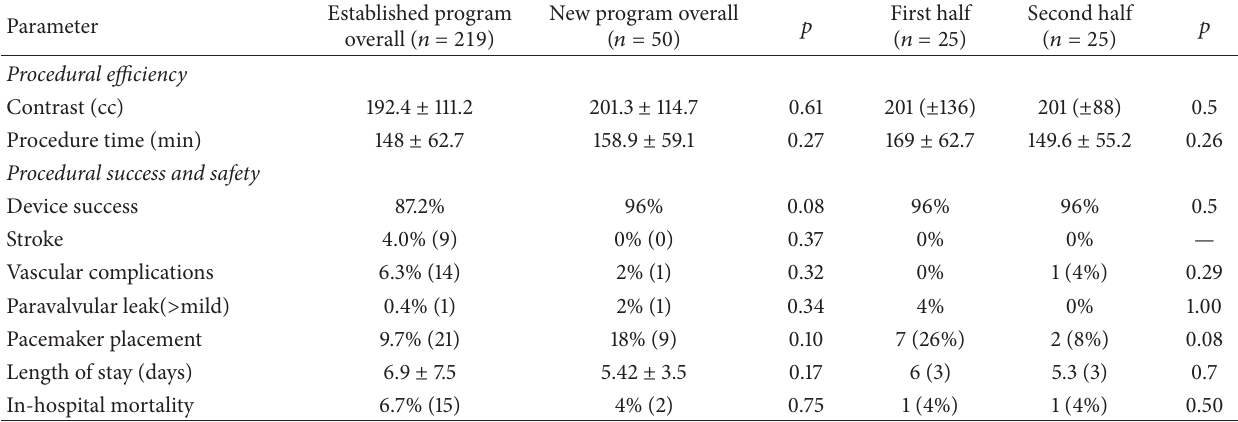
Table 2: Procedural efficiency, device success, and